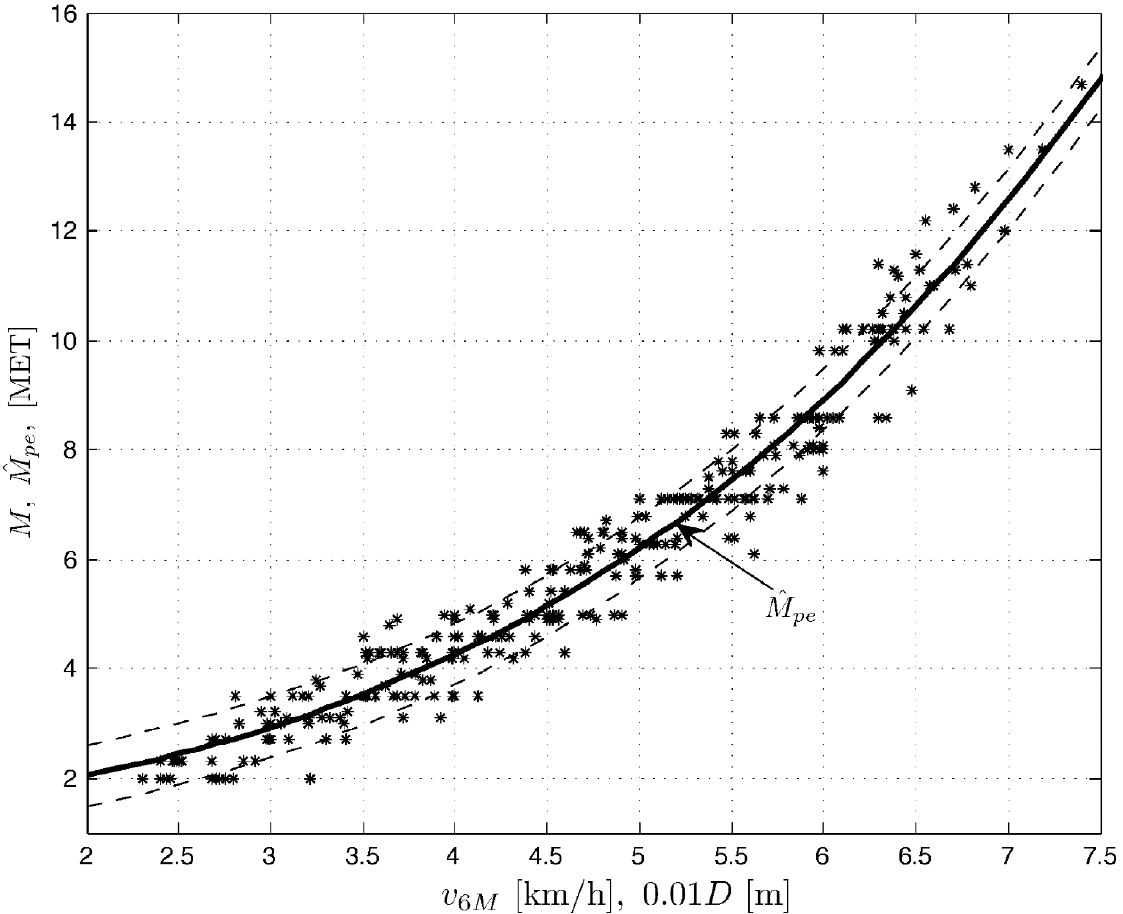
Figure 2. MET values based on the covered distance in the 6MWT and calculated into walk speed [km/h] [23].